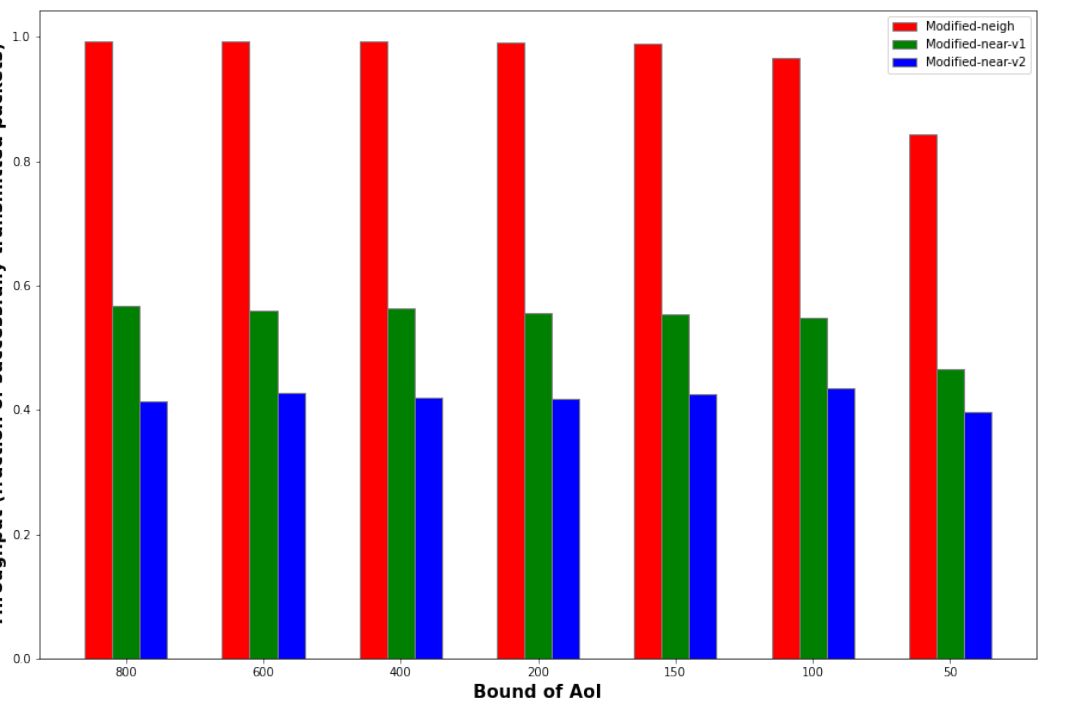
Figure 9. Dependence of throughput versus Bound of AoI for Modified-neigh, Modified-near-v1 and Modified-near-v2 protocols.